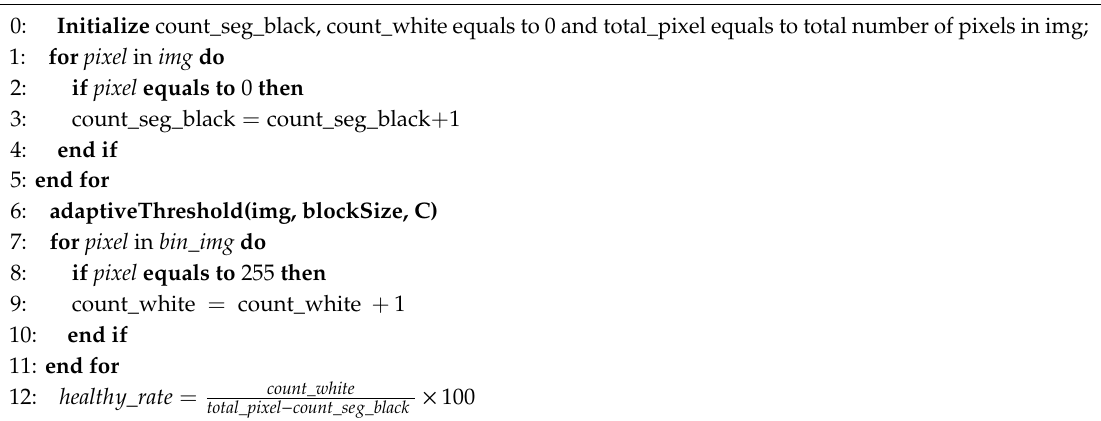
Algorithm 1: Wilt Severity